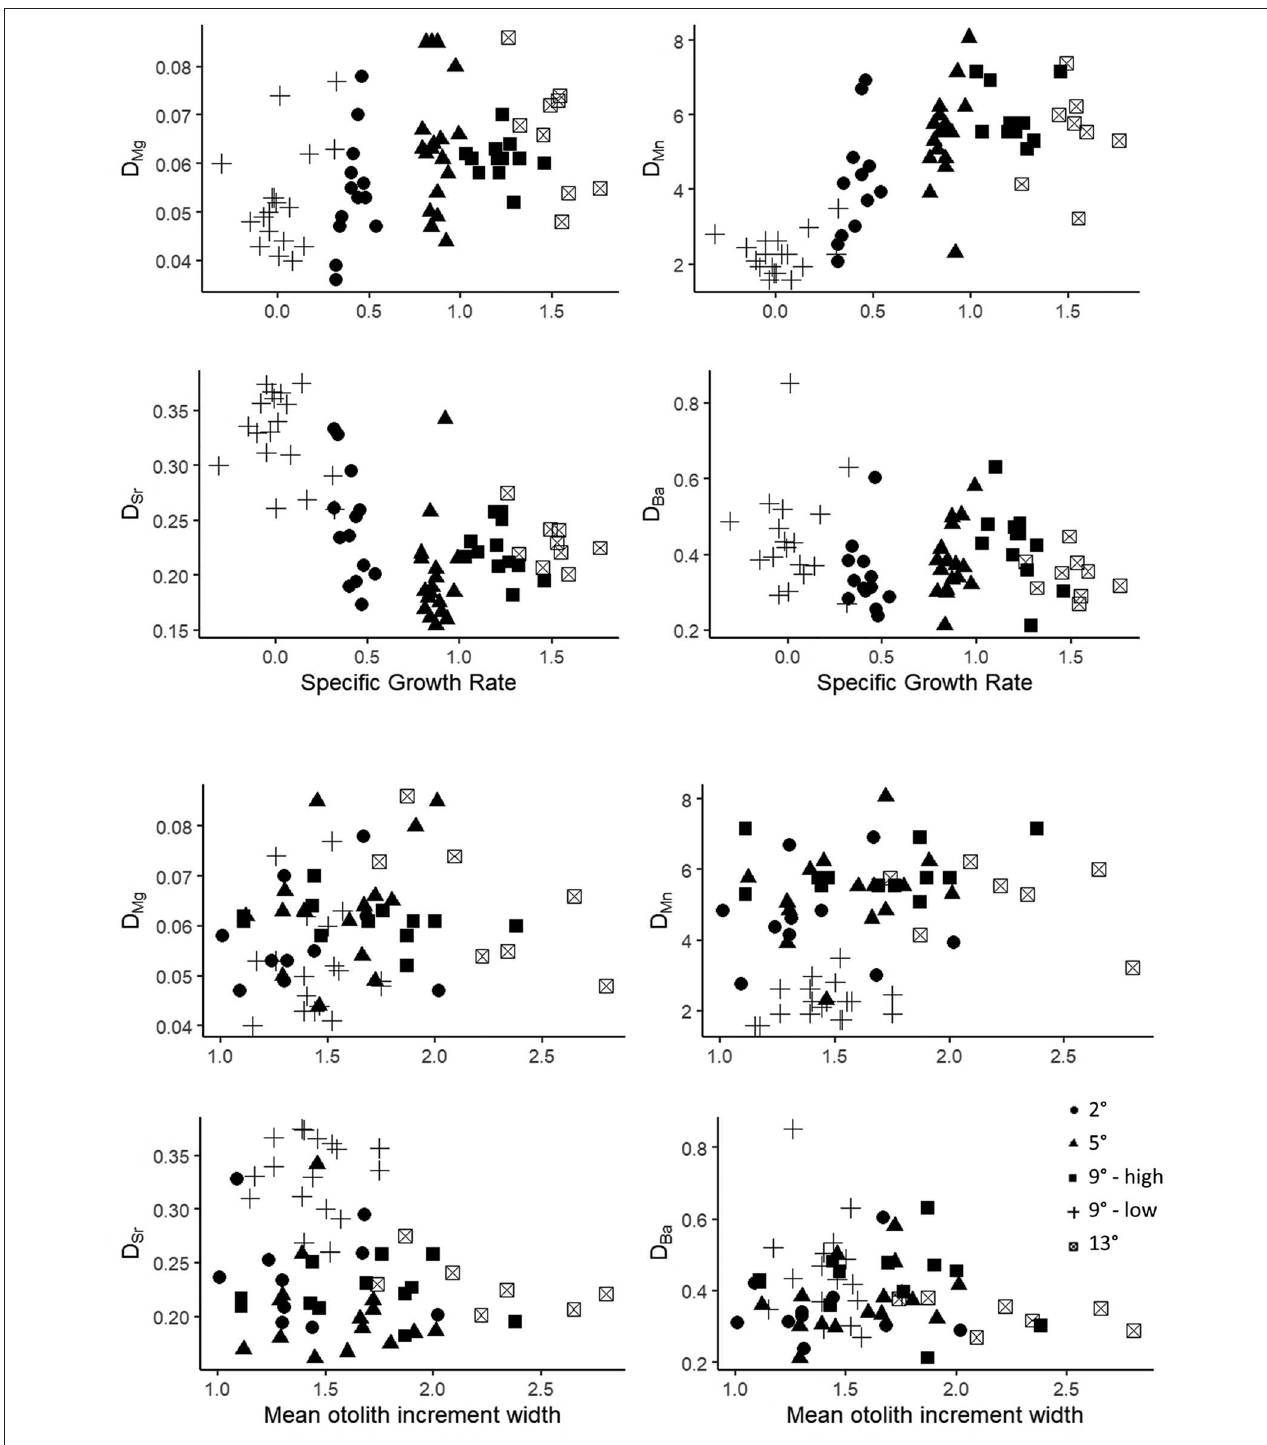
FIGURE 4 | Scatter plot of D Me and specific growth rate (% body mass d − 1 ) for all fish in the 2, 5, 9_low ration (9L), 9_high ration (9H), and 13 ◦ C treatments (top four graphs) and for D Me and mean otolith increment width (bottom four